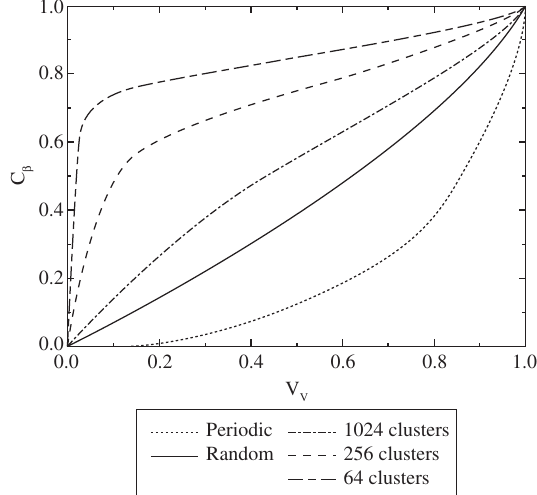
Figure 5. Contiguity, C